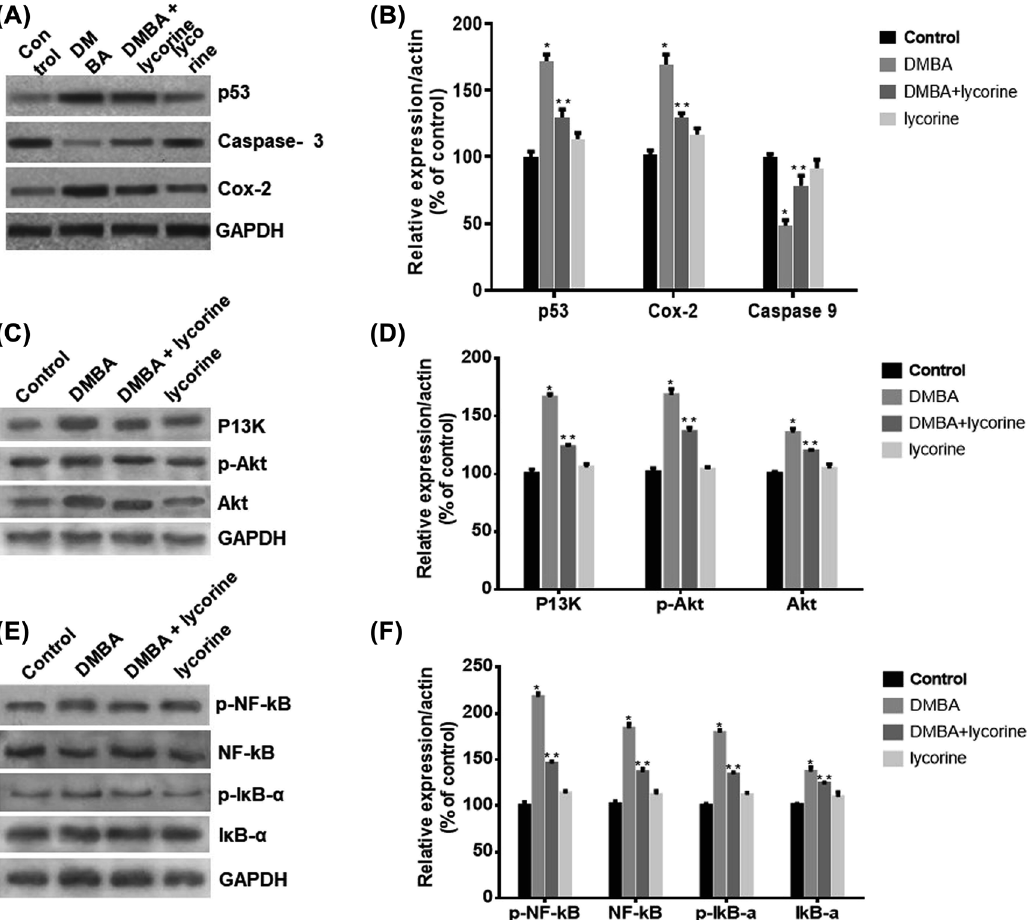
Figure 3: Effect of lycorine on apoptotic proteins p53, Caspase 9, Cox-2, P13K/Akt and NF- κ B modulation by western blot investigation. (A) The oral administration of lycorine reduced the p53 and Cox-2 and increased the caspase nine expression cheek pouches tissue of DMBA exposed experimental hamsters. (B) The graphical representation shows the relative expression of p53, Caspase 9, Cox-2 vs GAPDH. (C) The oral administration of lycorine reduced the P13K expression and inhibited the phosphorylation of Akt in the cheek pouches tissue of DMBA exposed experimental hamsters. (D) The graphical representation shows the relative expression of P13K, p-AKT/AKT vs GAPDH. (E) The oral administration of lycorine reduced the phosphorylated-I κ B- α and phosphorylated-NF- κ B expression in the cheek pouches tissue of DMBA exposed experimental hamsters. (F) The graphical representation shows the relative expression of p-I κ B- α /I κ B- α , NF- κ B/NF- κ B vs. GAPDH. Values are shown as mean ± SD (n=6). *p<0.05, **p<0.01 vs. control